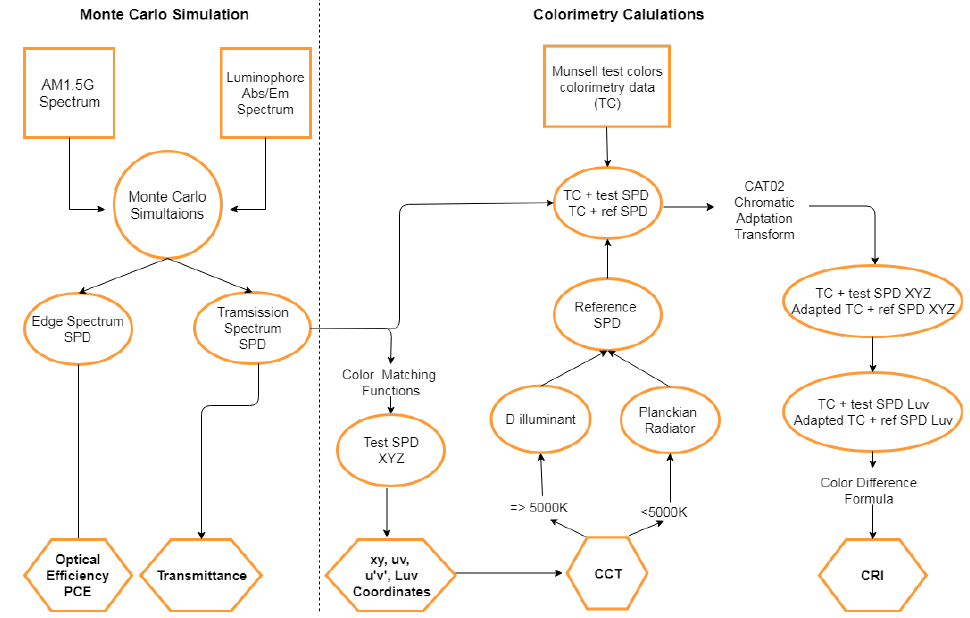
Figure 3. Structure of the methodology. Inputs are placed in a rectangular shape, the ellipses represent intermediate results, and the hexagons represent the end